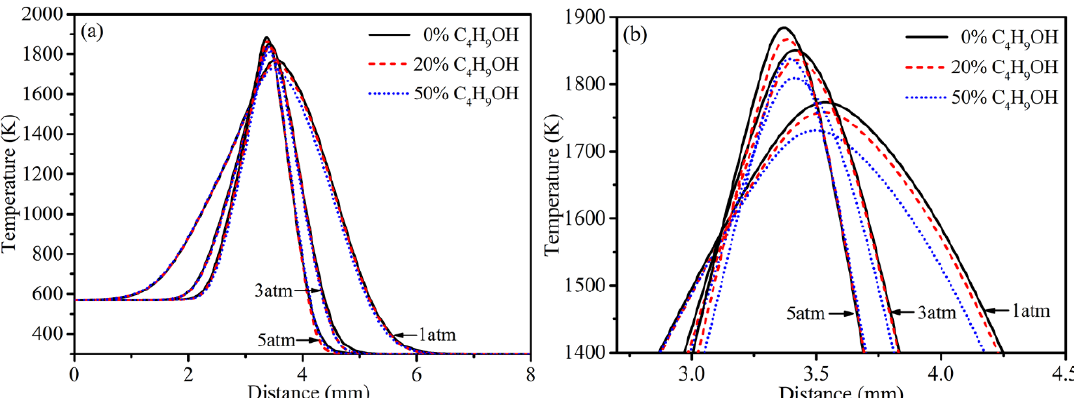
Figure 1. Temperature profiles of flame with different levels of n -butanol at different pressures: ( a ) total view, ( b ) locally enlarged view.